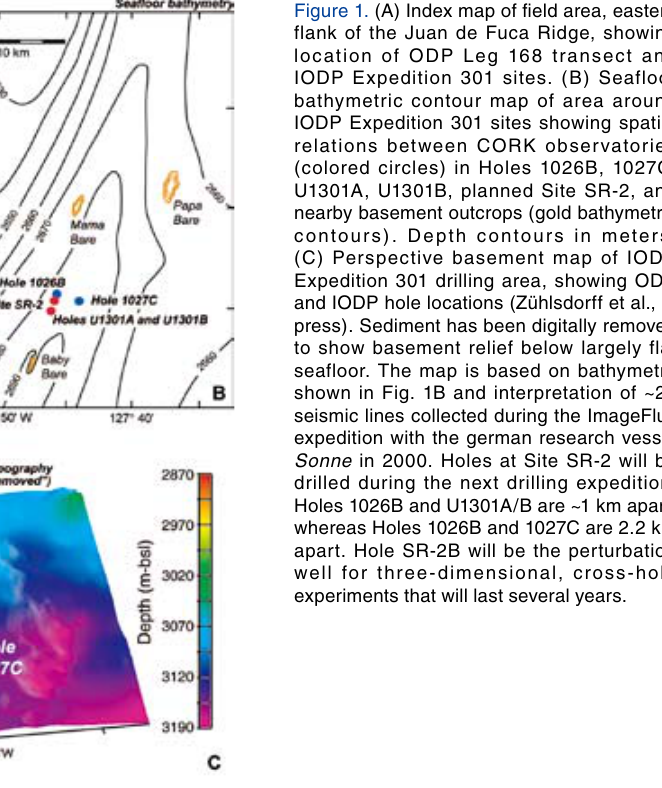
Figure 1. (A) Index map of field area, eastern flank of the Juan de Fuca Ridge, showing location of ODP Leg 168 transect and IODP Expedition 301 sites. (B) Seafloor bathymetric contour map of area around IODP Expedition 301 sites showing spatial relations between CORK observatories (colored circles) in Holes 1026B, 1027C, U1301A, U1301B, planned Site SR-2, and nearby basement outcrops (gold bathymetric contours). Depth contours in meters. (C) Perspective basement map of IODP Expedition 301 drilling area, showing ODP and IODP hole locations (Zühlsdorff et al., in press). Sediment has been digitally removed to show basement relief below largely flat seafloor. The map is based on bathymetry shown in Fig. 1B and interpretation of ~25 seismic lines collected during the ImageFlux expedition with the german research vessel Sonne in 2000. Holes at Site SR-2 will be drilled during the next drilling expedition. Holes 1026B and U1301A/B are ~1 km apart, whereas Holes 1026B and 1027C are 2.2 km apart. Hole SR-2B will be the perturbation well for three-dimensional, cross-hole experiments that will last several